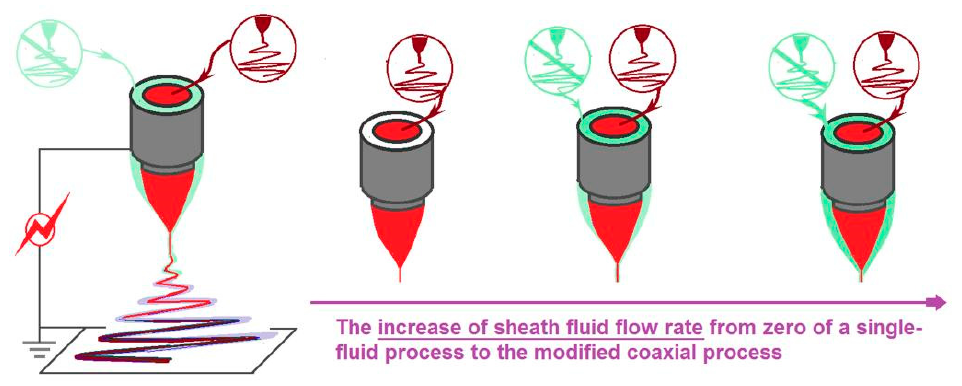
Figure 1. The role of sheath fluid in the modified coaxial electrospinning.